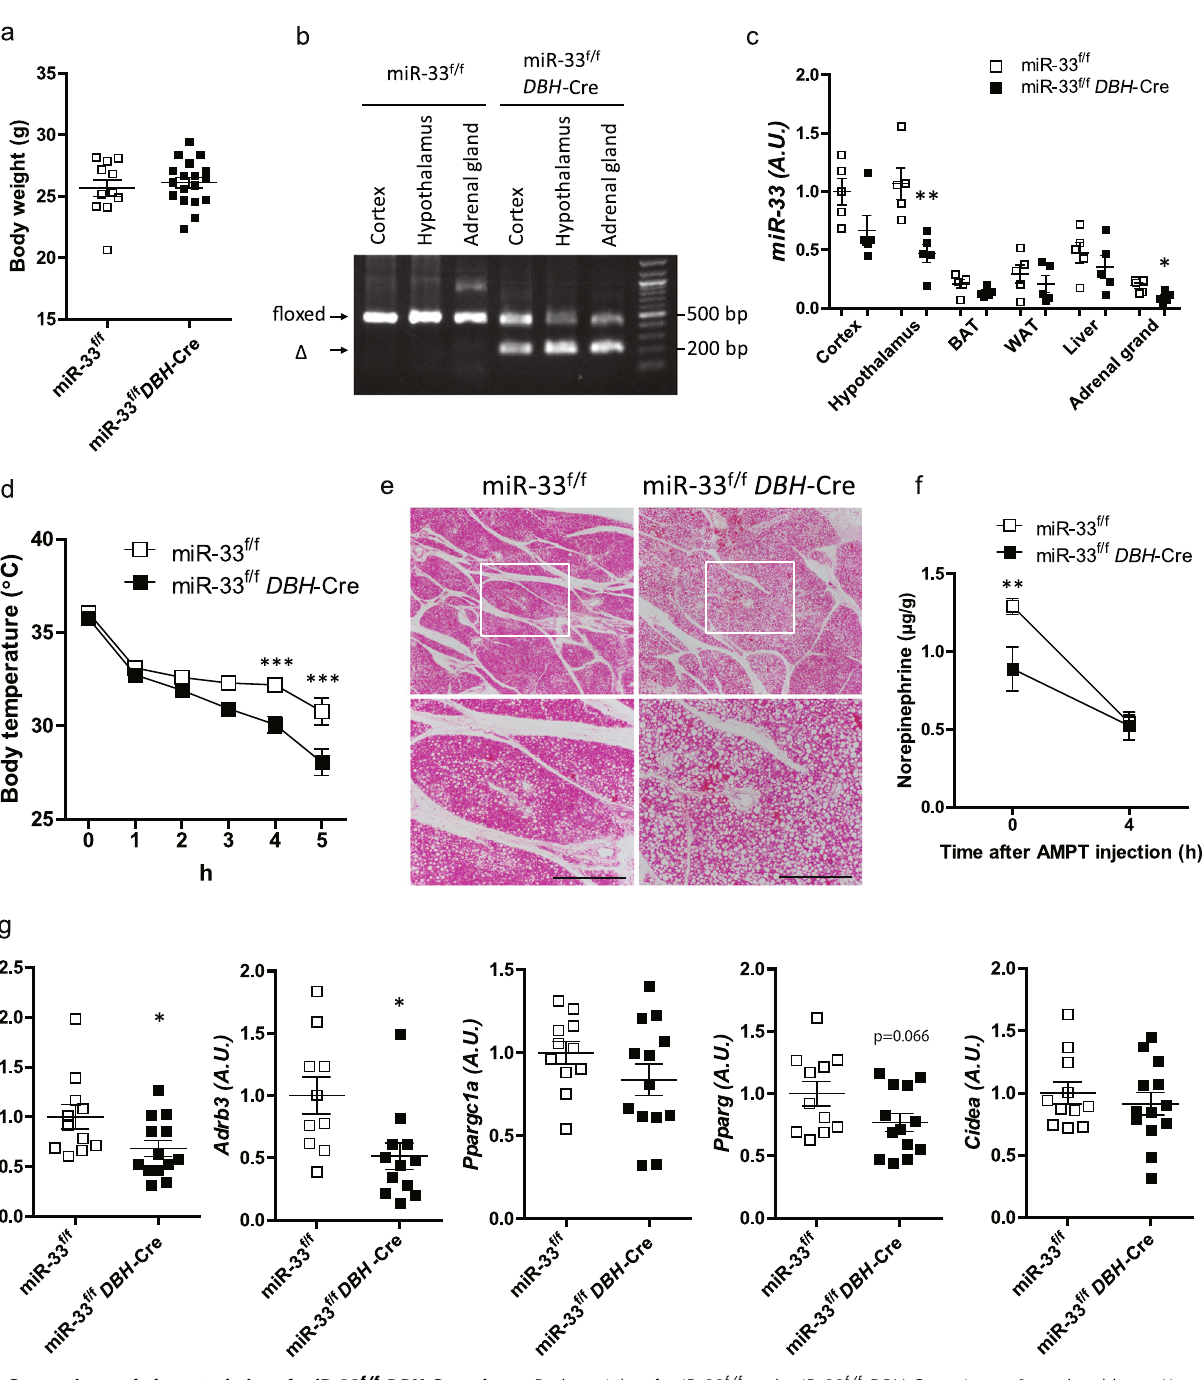
Fig. 5 Generation and characteristics of miR-33 f/f DBH -Cre mice. a Body weight of miR-33 f/f and miR-33 f/f DBH -Cre mice at 8 weeks old. n = 11 or 18 mice per group. b PCR analysis of genome DNA from the brain and the adrenal gland of miR-33 f/f and miR-33 f/f DBH -Cre mice. A representative image from two independent experiments. c Quantitative real-time PCR analysis of miR-33 in organs of miR-33 f/f and miR-33 f/f DBH -Cre mice. n = 5 mice per group, ** p < 0.01, * p < 0.05, two-sided Mann – Whitney test. The expression of miR-33 f/f cortex is set to 1. d Serial core body temperature change of miR- 33 f/f and miR-33 f/f DBH -Cre mice kept at 4 °C. n = 11 – 13 mice per group, *** p < 0.001, two-way repeated-measures ANOVA with Bonferroni ’ s post hoc test. e Representative images of HE staining for the BAT of miR-33 f/f and miR-33 f/f DBH -Cre mice kept at 4 °C for 5 h. n = 4 mice per group. Scale bar, 200 μ m (lower). f Norepinephrine contents in BAT before and after AMPT injection. n = 5 – 7 mice per group, ** p < 0.01, two-way ANOVA with Bonferroni ’ s post hoc test. g Quantitative real-time PCR analysis of thermogenic genes in the BAT of miR-33 f/f and miR-33 f/f DBH -Cre mice kept at 4 °C for 5 h. n = 10 – 13 mice per group, ** p < 0.01, * p < 0.05, two-sided unpaired t test. All data are presented as mean ± SEM.